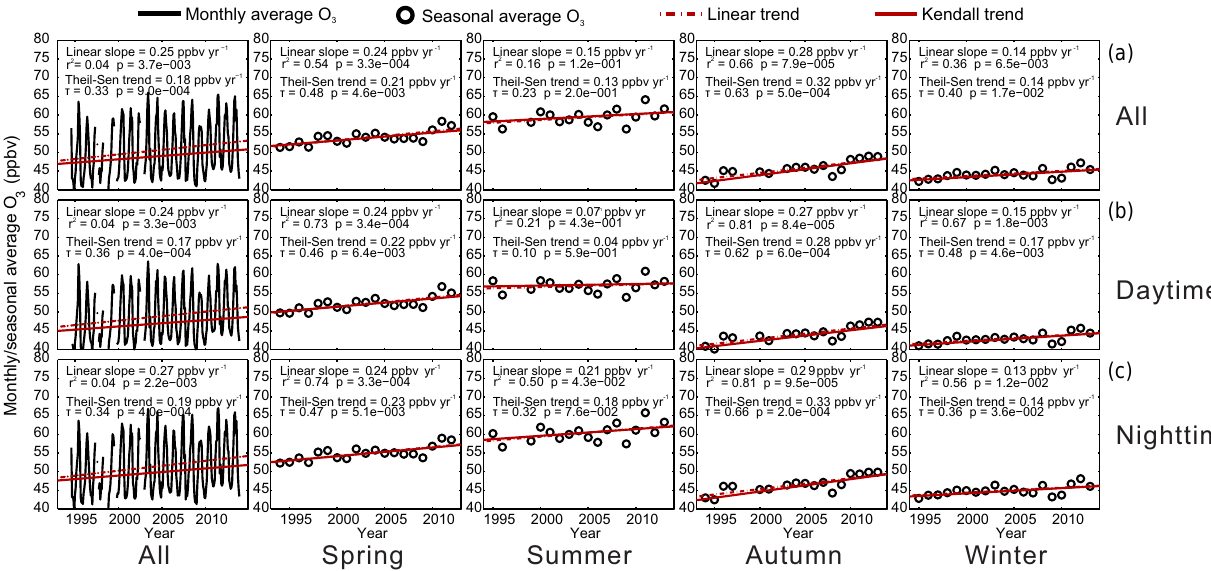
Figure 5. (1) Monthly, (2) spring (MAM), (3) summer (JJA), (4) autumn (SON) and (5) winter time average all day (a) , daytime (b) and nighttime (c) surface ozone mixing ratio during 1994–2013 (black solid curves or black circles) and its trend (red lines: dotted line stands for the linear variation and solid line stands for the Theil–Sen trend estimates). Table 1. The linear slope, 95% confidence interval (in ppbvyear 1 ) and the p values (in parentheses) of all-year and seasonal average surface ozone mixing ratio for the all-day data and for the daytime and nighttime data subsets during